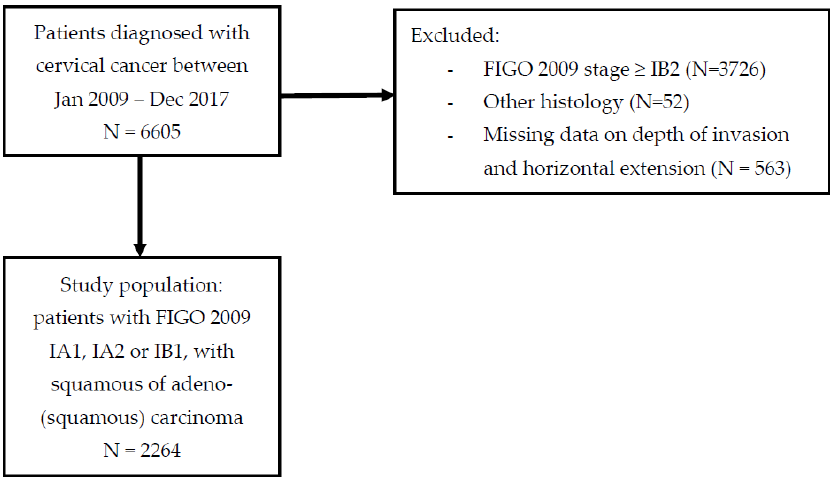
Figure 1. Patient selection flowchart.